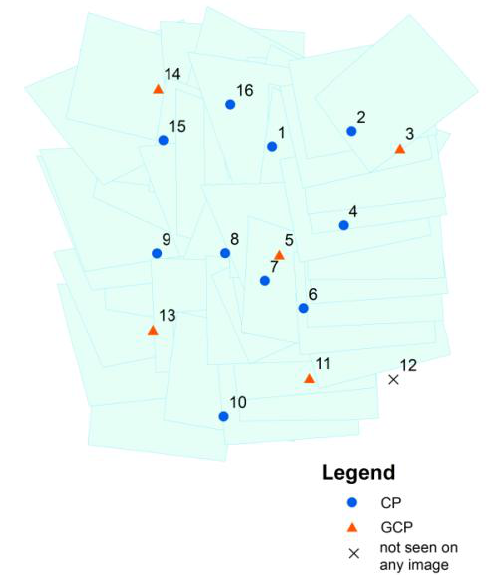
Table 1 – Bundle-block adjustment results (15 and 5